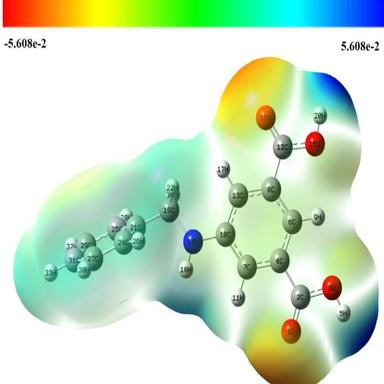
Molecular electrostatic potential (MEP) of H2L.